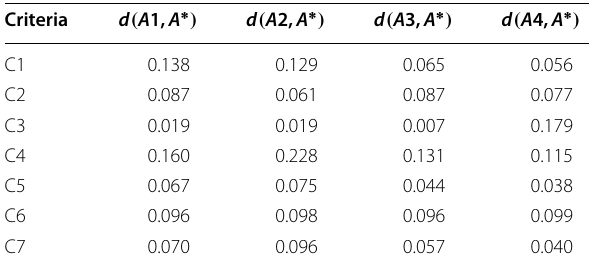
Table 12 Distances between A i ( i = 1,2,3, 4 ) and A* for each criterion Criteria